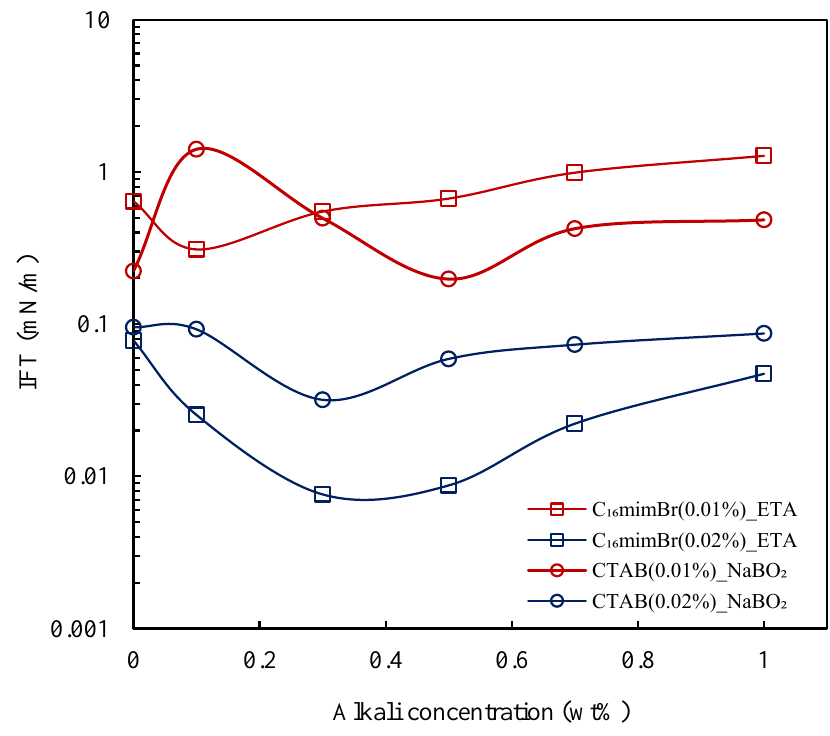
Figure 8. Effect of alkali on the oil – aqueous IFT.